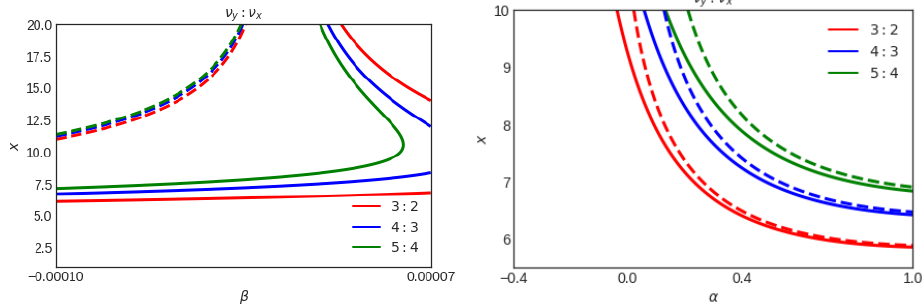
Figure 10. The first panel shows the location of three cases of resonances between vertical and radial epicyclic frequencies with respect to β . The thick line shows α = 0.4 and the dashed line α = − 0.4. The second panel represents the location of three cases of resonances between the vertical and the radial epicyclic frequencies with respect to α . The thick line shows β = − 0.00001 and the dashed line β = 0.00001.